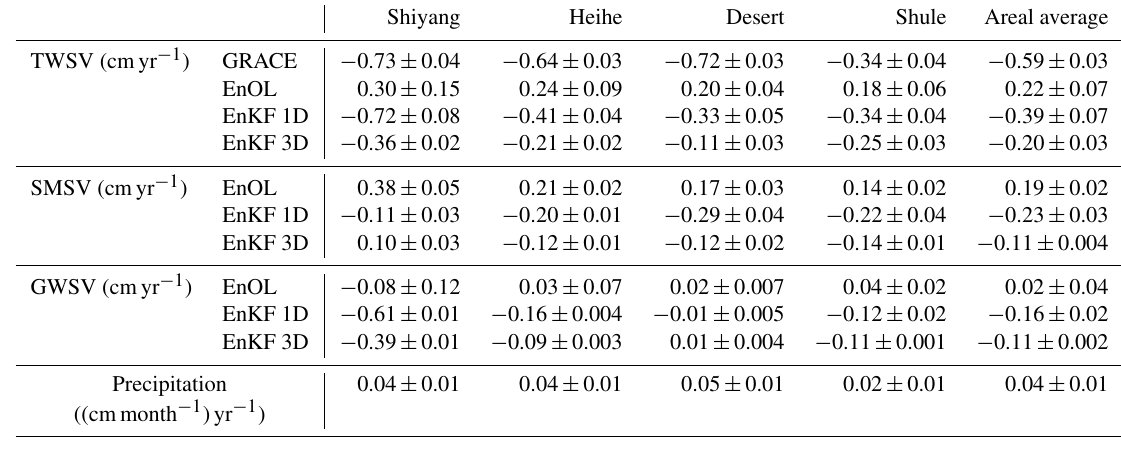
Table 7. TWSV, SMSV, GWSV, and precipitation estimated long-term trends in four different basins computed between April 2002 and December 2010. Areally averaged values for the entire Hexi Corridor are also given.